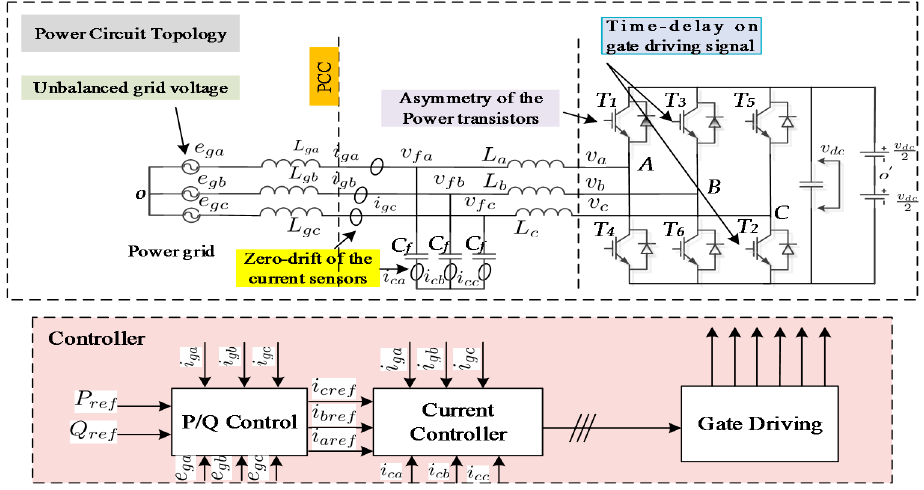
Figure 1. The influences that might cause dc-component at the PCC point of grid-connected converters.